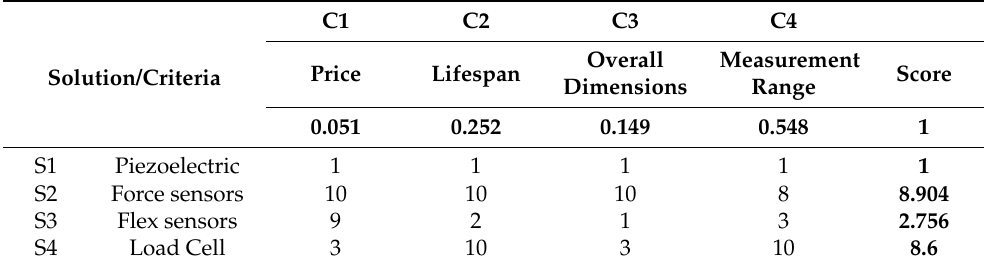
Table 4. PUGH matrix for the